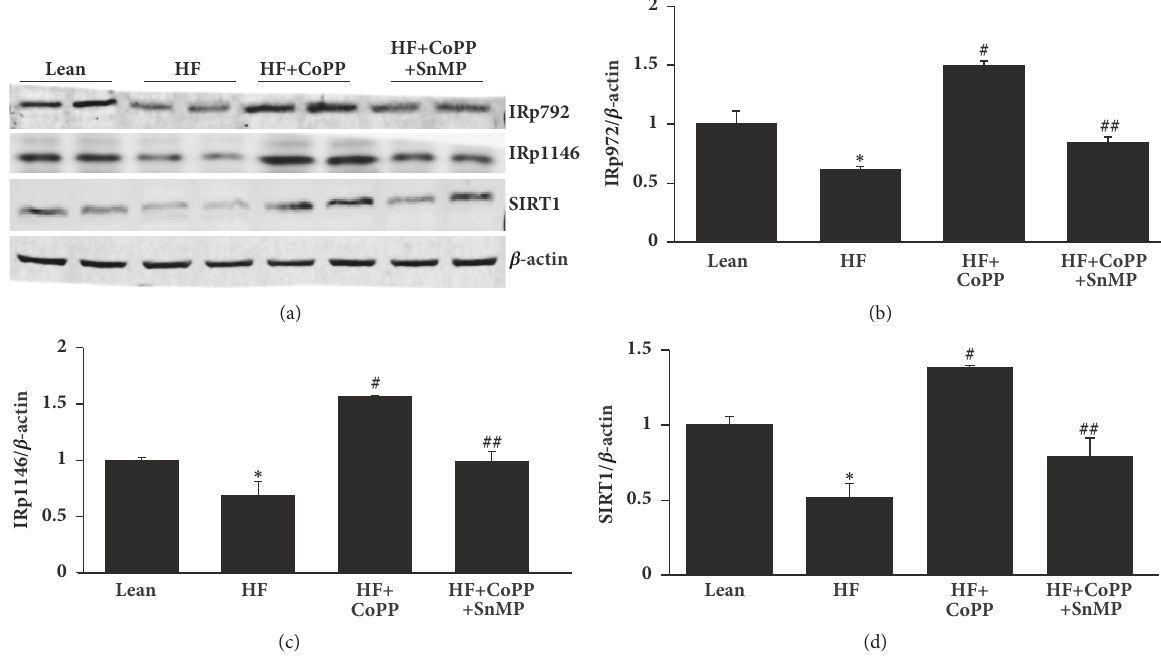
Figure 5: HO-1 upregulation increases hepatic pAKT, pAMPK, and insulin receptor phosphorylation levels. Representative western blots (a) and densitometry analysis of (b) IRp972, (c) IRp1146, and (d) SIRT1 in hepatic tissues of control lean mice, HF fed mice, HF fed mice + CoPP, and HF fed mice + CoPP + SnMP. Results are mean ± SE, n=4, ∗ p < 0.05 versus lean mice, #p < 0.05 versus HF fed mice, and ##p < 0.05 versus HF fed mice +